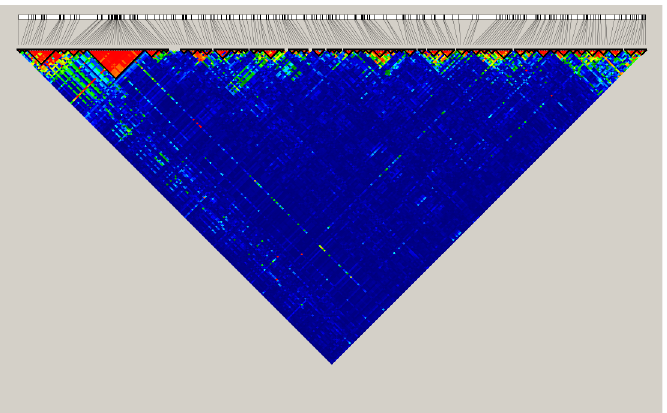
Fig 2. Linkage disequilibrium analysis of 262 SNPs from chromosomal region 16:53 500 000–55500 000. Pairwiselinkageexhibitedas LD coefficients(|D’|) betweeneach pair of SNPs. Minor allelefrequencies of all SNPs used in this analysisare (cid:21) 10%. Boldedtrianglesshow haplotypeblocks. Data were generated with